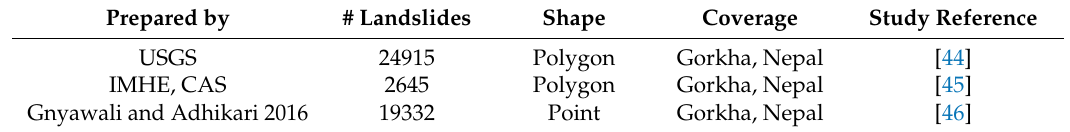
Table 1. Landslide inventories prepared as part of different studies